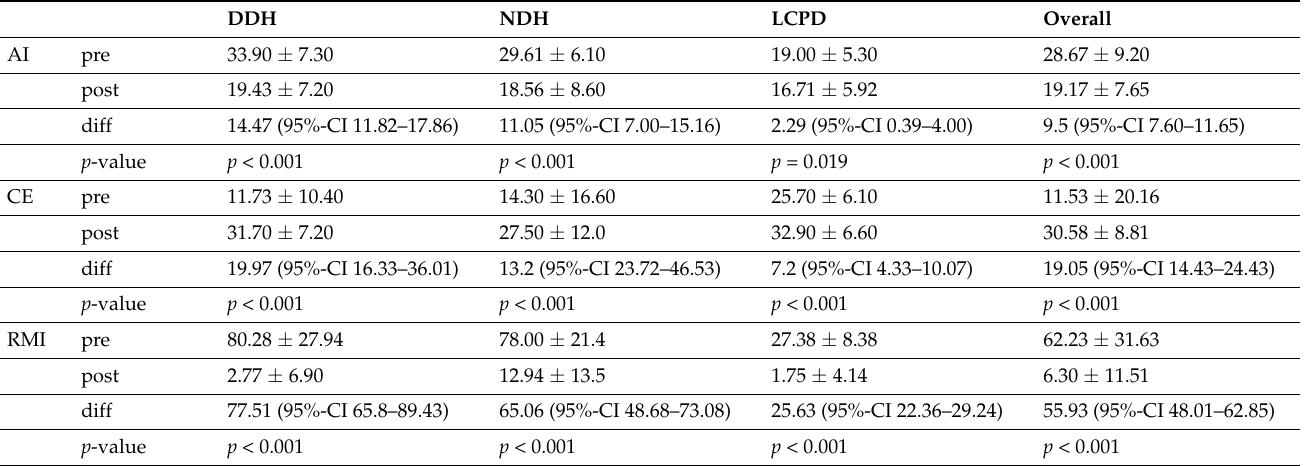
Table 3. Pelvic geometry [27].